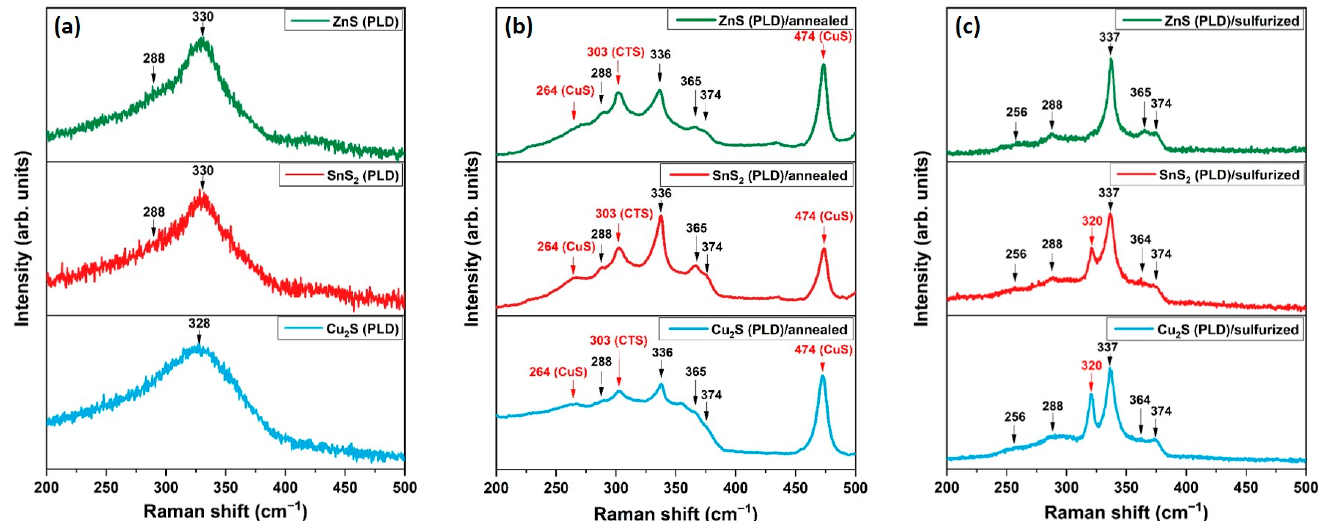
Figure 3. Raman spectra of the MSPLD samples ( a ) as-deposited, ( b ) annealed without sulfur at 500 °C, and ( c ) sulfurized at 500 °C.